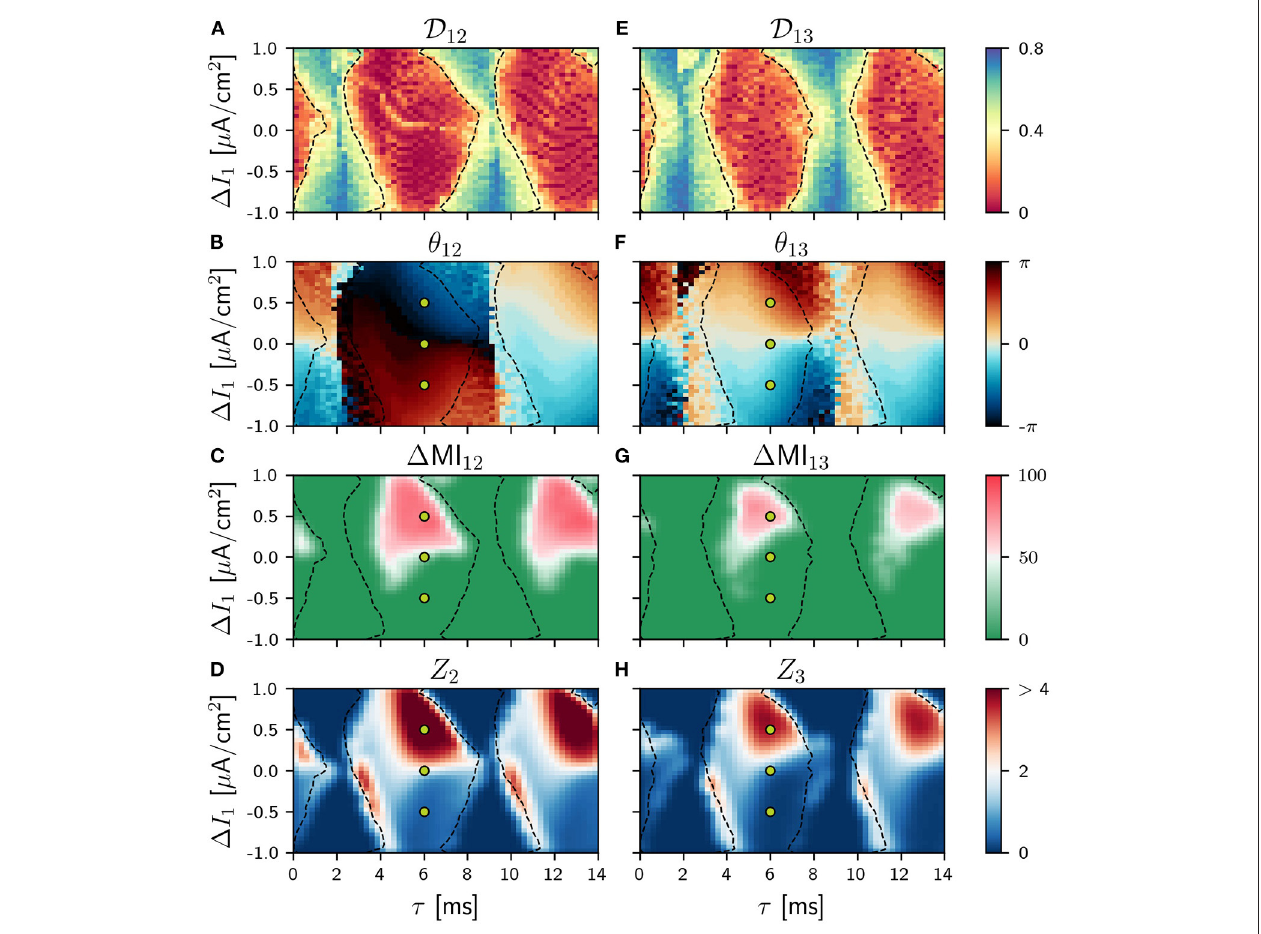
FIGURE 2 | Population 1 as the sender in the V-motif. Phase locking index D ij (A,E) . Phase difference θ ij (B,F) . Difference 1 MI ij (C,G) when a slow modulation is injected. Integral of the absolute value of the nPRC Z i (D,H) when a fast signal is injected. All of them as a function of the delay and the frequency mismatch 1 I in population